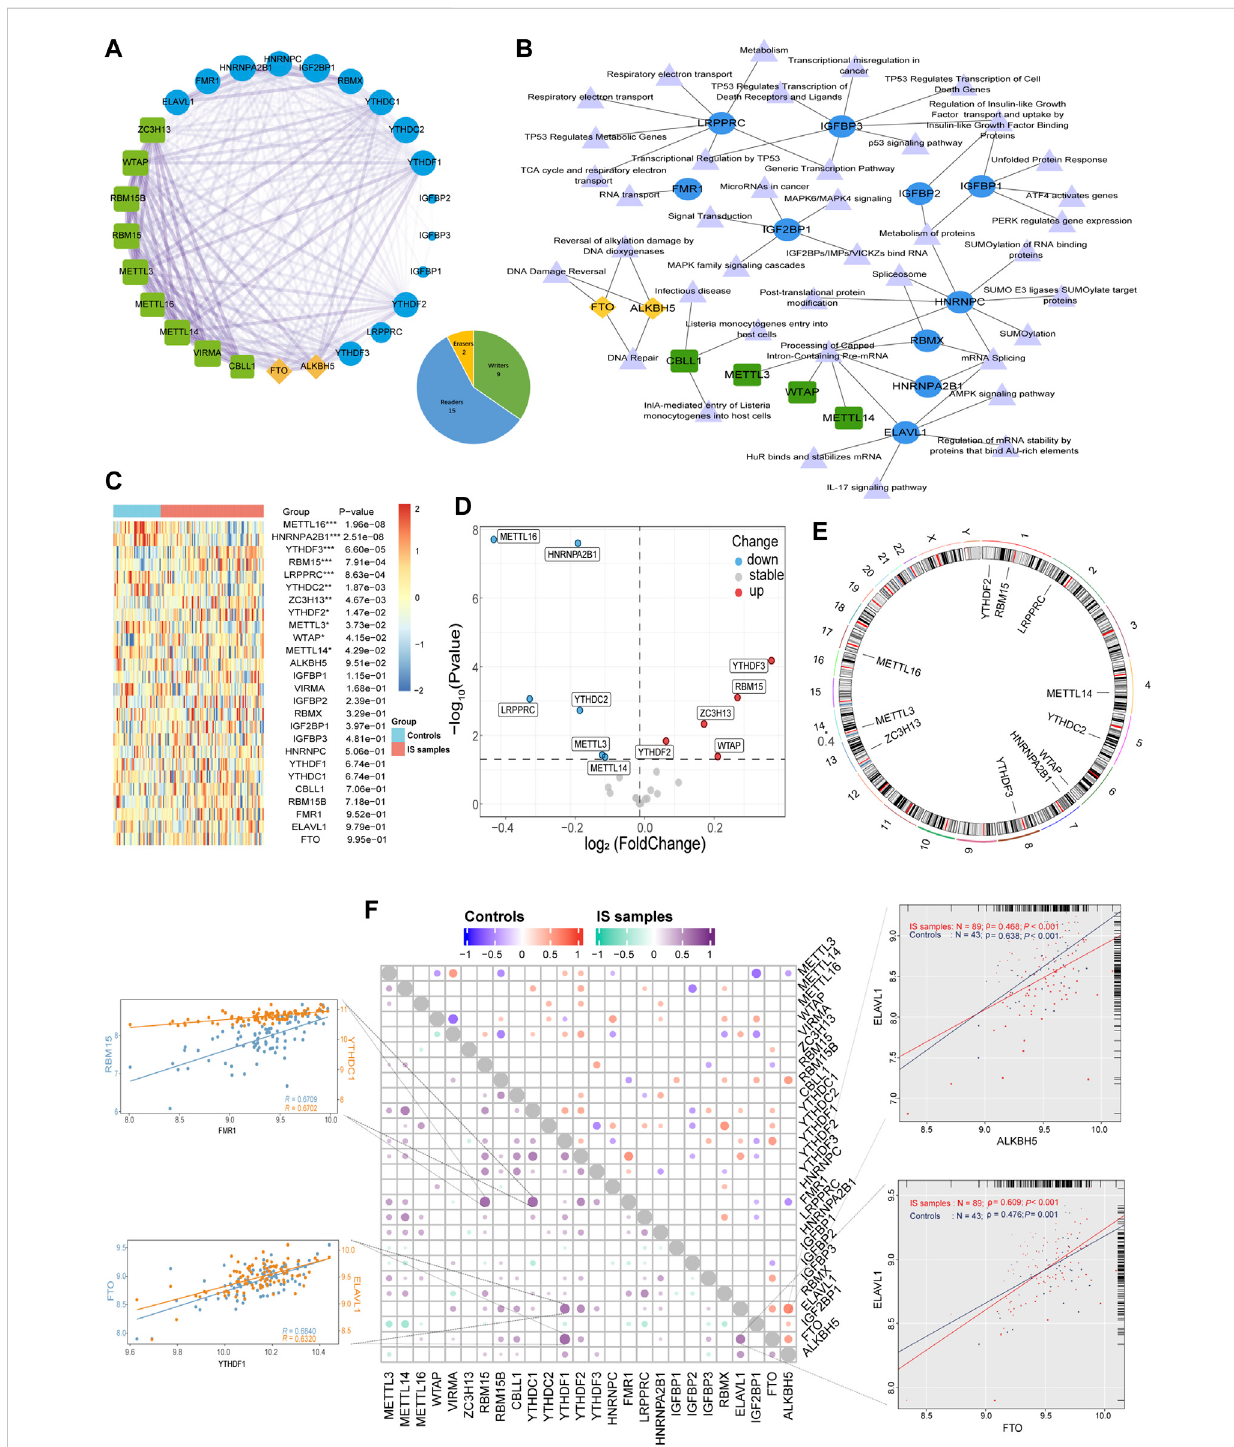
FIGURE 1 The synergistic effects not only existed inthe same type of m6A regulators but also between differenttypesof m6A regulators. (A) The composition summaryofm6AregulatorsandthePPIinteractionsamong26m6Aregulators. (B) m6Aregulator-pathwayinteractionnetwork. (C) Expression heatmap of the 26 m6A regulators. (D) Volcano plot of the expression differences of 26 m6A regulators. (E) Chromosomal positions of the differential m6A regulators. (F) Dot-plot demonstrating the correlations between 26 m6A regulators in controls and IS samples. The four respective scatterplots show the highest correlation between m6A regulators, the most signi fi cant positive correlation of FMR1 with RBM15 and YTHDC1, and the most signi fi cant positive correlation of YTHDF1 with FTO and ELAVL1, the most signi fi cant positive correlation of FMR1 with RBM15 and YTHDC1, ELAVL1, and ALKBH5 with the most signi fi cant positive correlation in controls, ELAVL1 and FTO with the most signi fi cant positive correlation in IS samples. * p < 0.05, ** p < 0.01, and *** p < 0.001, “ ns ” indicates no signi fi